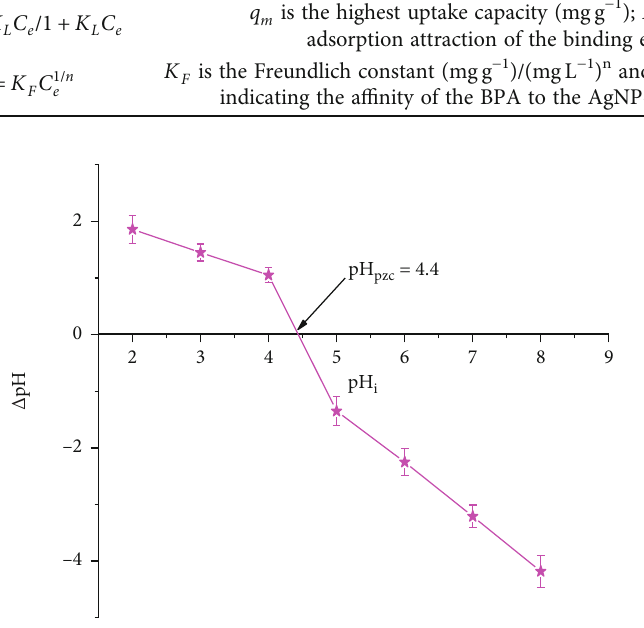
Figure 1: Point zero charge of AgNP-SB- β CD nanocomposites.